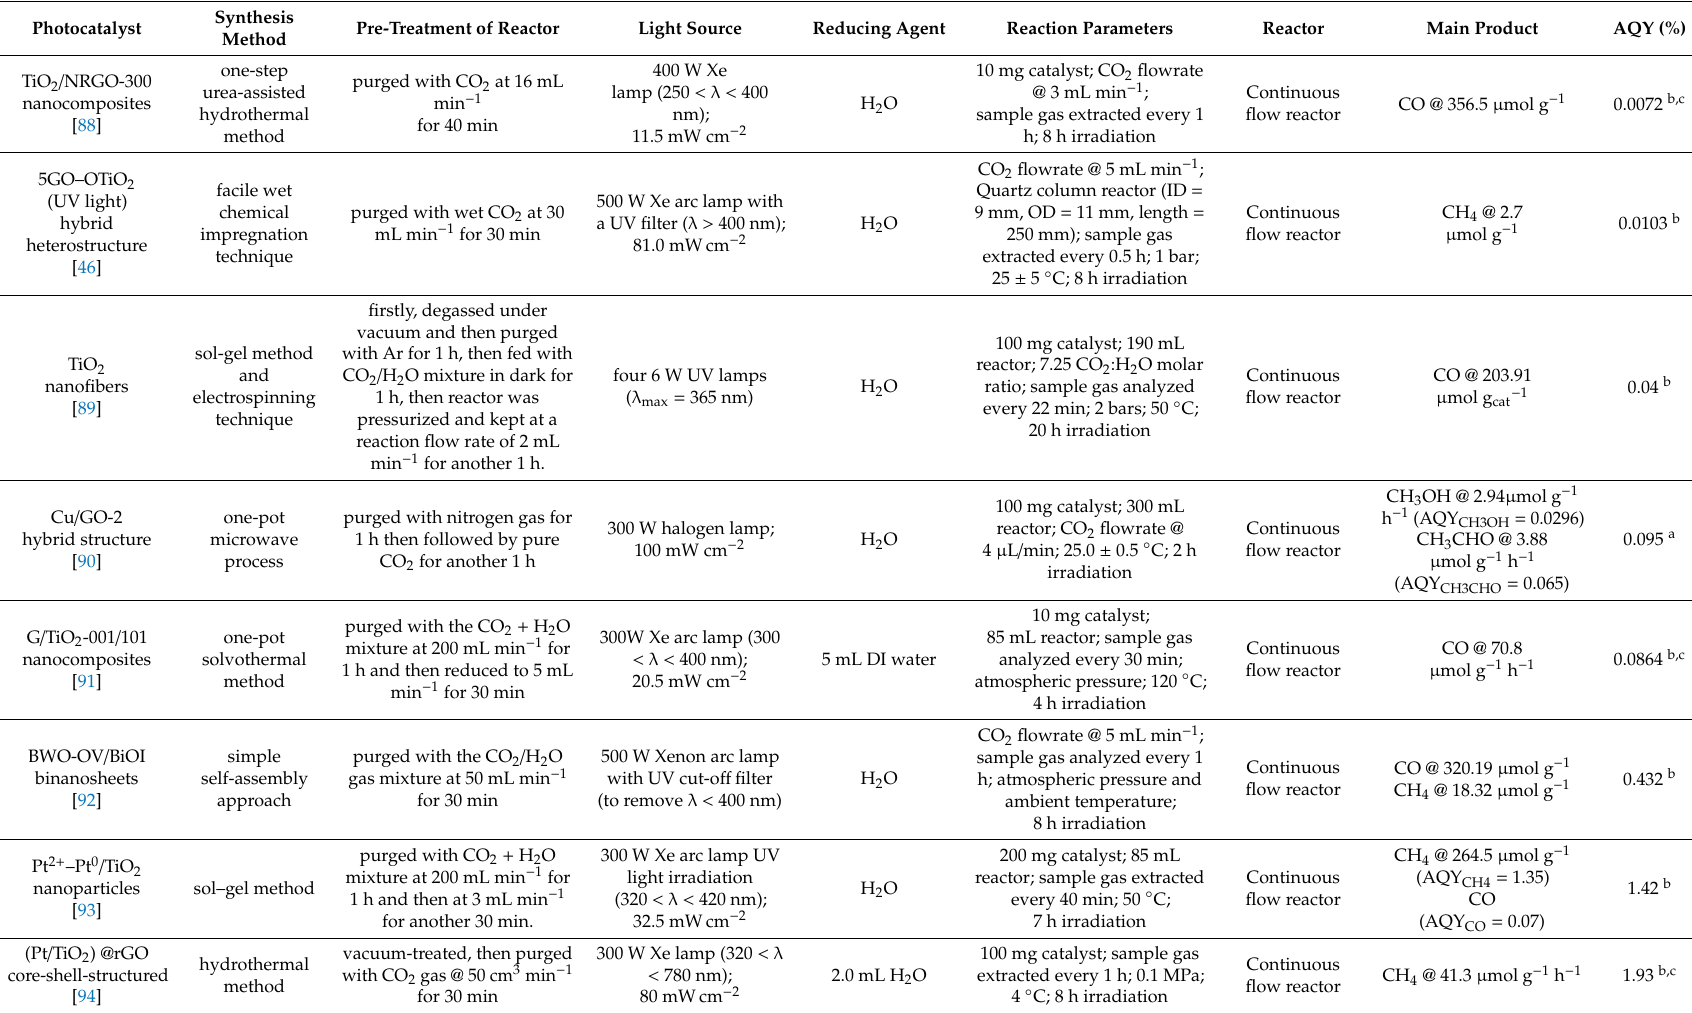
Table 3. Summary of operating parameters used by other research works for photocatalytic CO 2 reduction using Continuous flow reactor.